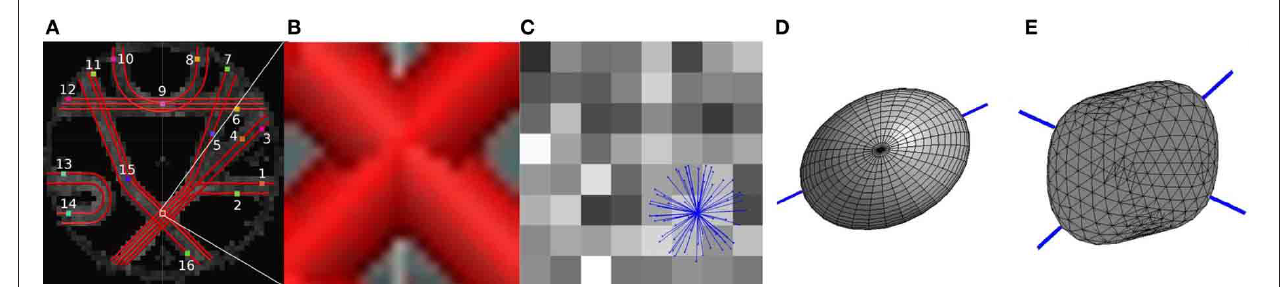
sensitizing directions, indicated with blue vectors. (D) The diffusion ellipsoid computed from the diffusion tensor. (E) The dODF. Blue lines in (D) and (E) indicate the fiber orientations obtained from the diffusion tensor and the dODF, respectively.